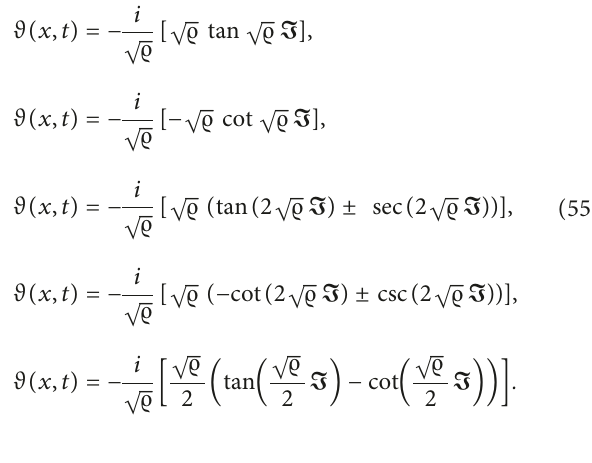
appears in equation x,t ( )